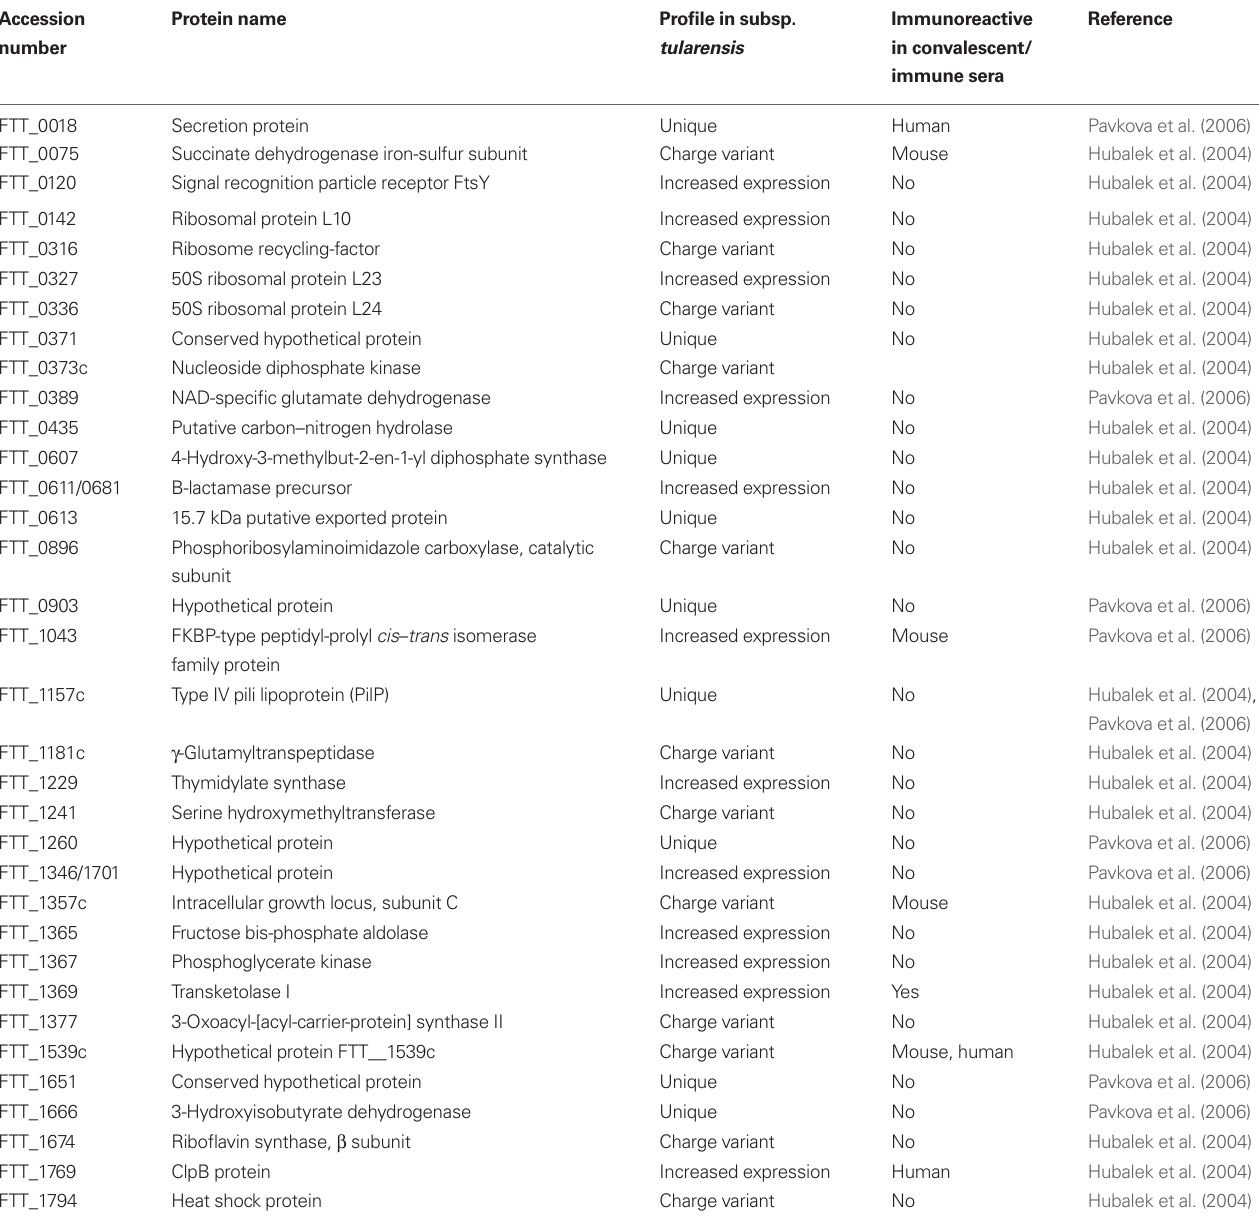
Table 1 | Proteins observed at higher levels, or only at detectable levels in subspecies tularensis